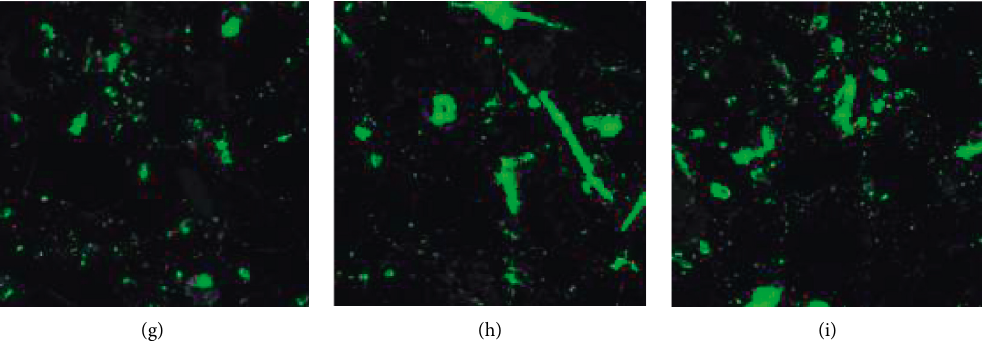
Figure 9: Imaging by RapidAir457 system. (a) Imaging of MC20-2. (b) Imaging of MC20-3. (c) Imaging of MC20-4. (d) Imaging of MC60-2. (e) Imaging of MC60-3. (f) Imaging of MC60-4. (g) Imaging of MC80-2. (h) Imaging of MC80-3. (i) Imaging of MC80-4.